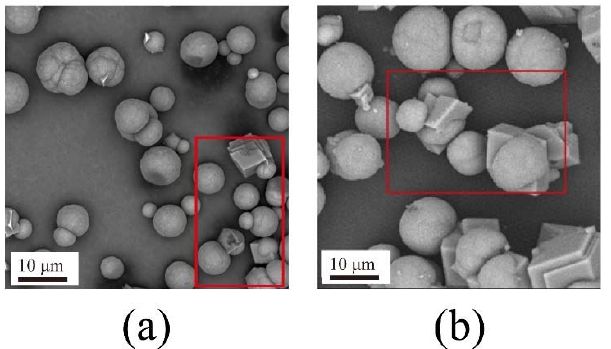
Figure 14. SEM images of spherical vaterite particles attached onto cubic calcite particle surfaces in deionized water ( a ) and in deionized water containing nanobubbles ( b ) (after 0.5 h passed).